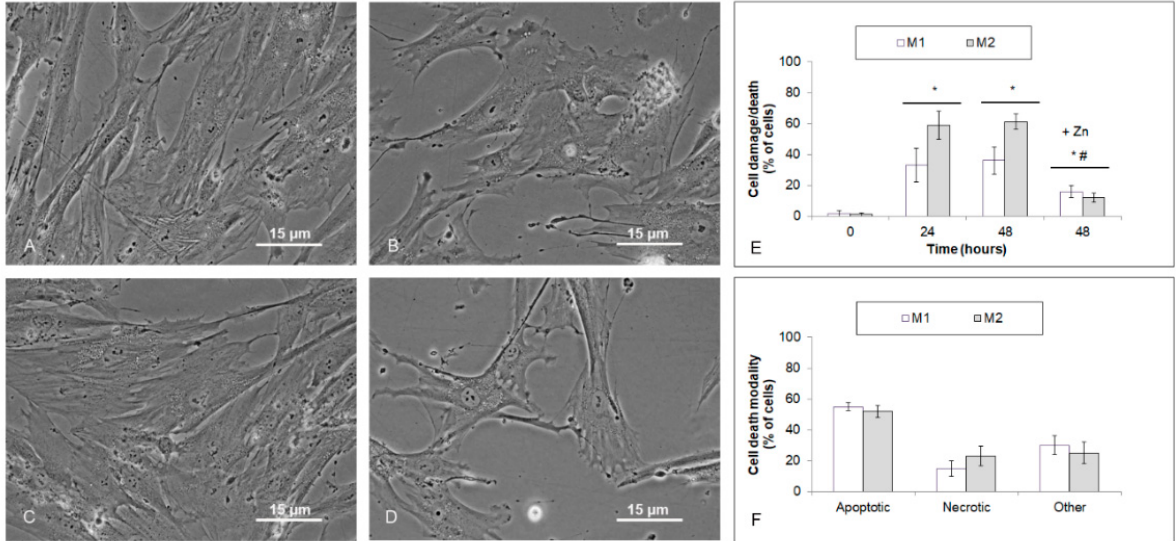
Figure 6. Cell damage/death of human melanoma explant cultures M1 (low free zinc) and M2 (high free zinc) exposed to 25 µM TPEN during 48 h. Cells were treated with TPEN alone or with zinc sulfate (100 µM) and their effect on cell damage/death was evaluated by morphometric analysis of micrographs obtained from time-lapse microscopy ( A – E ) and propidium iodide ( F ). Results represent means ± SD of four experiments. ( A – D ) Phase contrast microscopy, 600×. ( E ) p < 0.05 * Significantly higher compared to the beginning of treatment, p < 0.05 # Significantly lower than TPEN only treated cells at 48 h with one-way-Anova test and Dunnett’s post test for multiple comparisons.